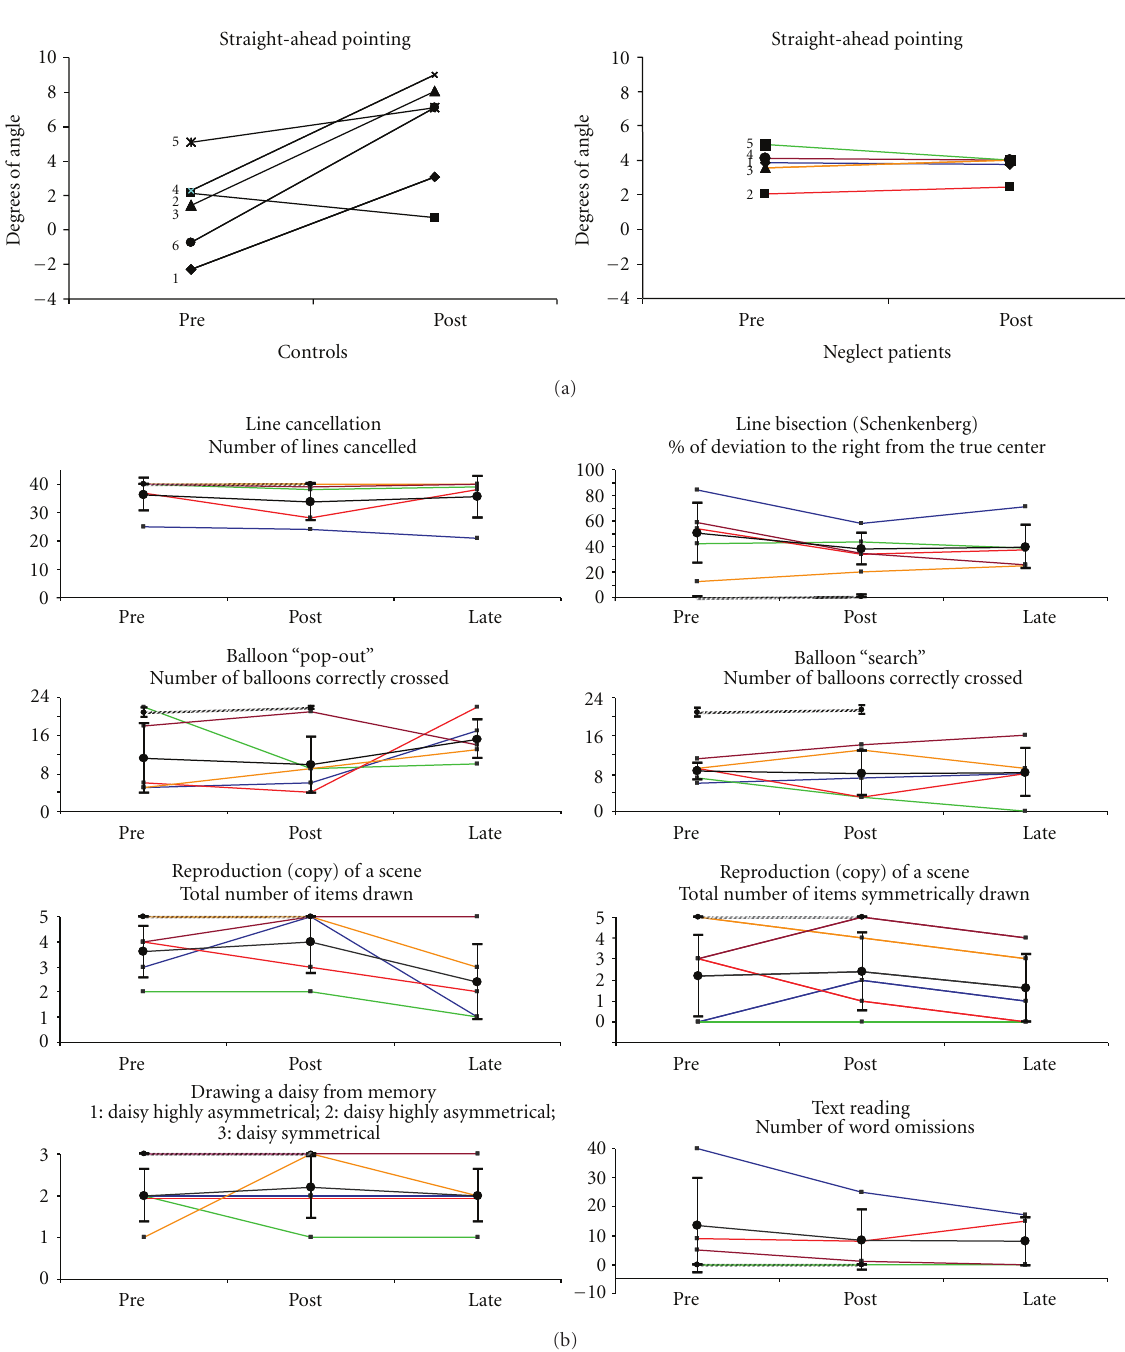
Figure 3: Straighthead pointing movements before and after prism adaptation for healthy controls (left) and neglect patients (right). (a) For each subject, the average end-position of straightahead pointing movements is represented before (pre) and after (post) left-deviating prism adaptation. Deviation from body midline is displayed in degrees of angle in positive value for right deviation and negative value for left deviation. Numbers refer to patient’s identification (cf. Table 1) with the following color code: patient 1 (blue); patient 2 (red); patient 3 (orange); patient 4 (purple); patient 5 (green). (b) Left spatial neglect assessment before (pre), immediately after (post), and 2hours after (late) prism adaptation. For each test, the graph represents the mean score ± 95% confident interval for the group of five patients at each session. Individual curves are represented using the same color code as in Figure 3(a). Moreover, performances of the healthy controls (95% confident interval) are displayed in cross-hatching. For tests and scores description see Section